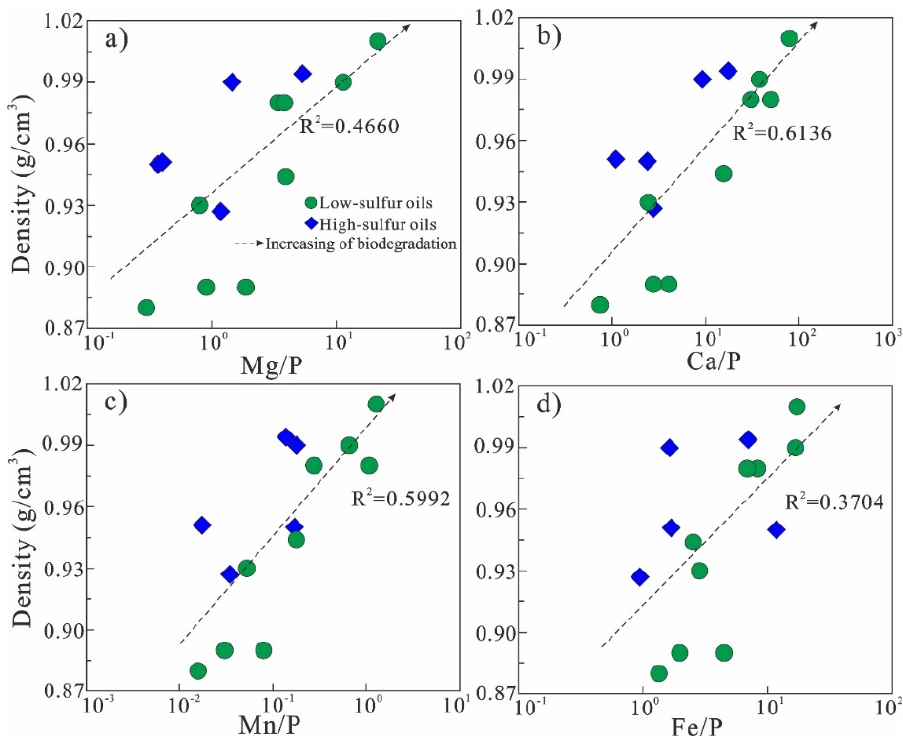
Figure 13. Cross plots of Mg/P ( a ), Ca/P ( b ), Mn/P ( c ) and Fe/P ( d ) ratios versus the densities of oil samples in this study.